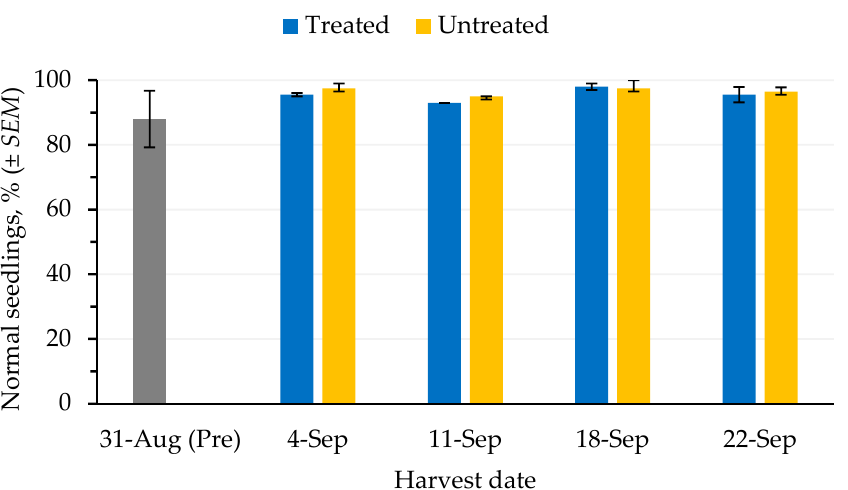
Figure 4. Mean standard germination test values in percentage for corn hybrid seeds harvested at different harvest dates in 2015. 31-Aug (Pre) refers to harvest before defoliant application; all other harvest dates are post-defoliant application. Aug and Sep indicate the months of August and Sep- tember. Blue columns are the values for seed harvested from plants treated with a defoliant; yel- low columns are the values for seed harvested from the untreated control plants. Bars indicate standard error of the mean ( SEM ). Means are not significantly different ( p ≤ 0.05).